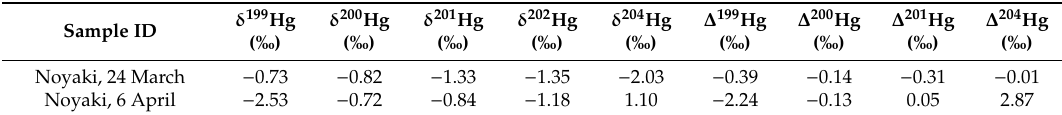
Table 5. Background-corrected δ x Hg and ∆ x Hg for TGM from the open field burning (Noyaki).